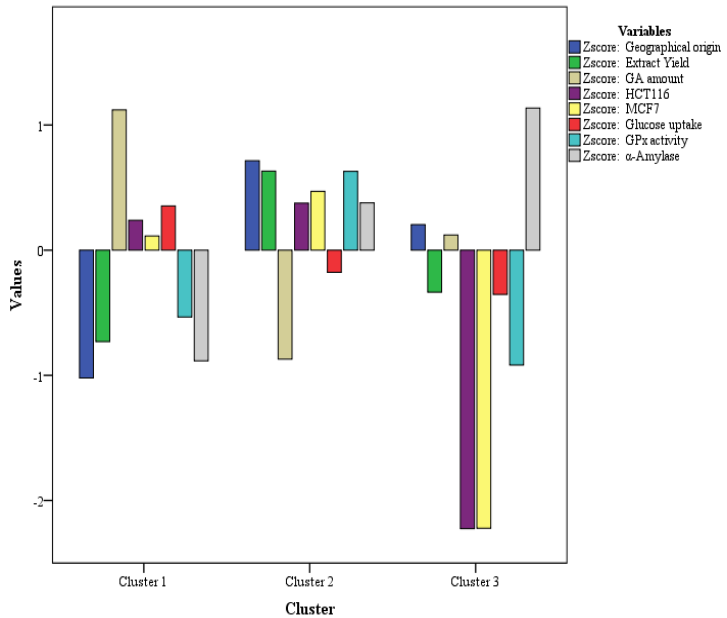
Table 5. K-mean analysis for different geographical samples of licorice.